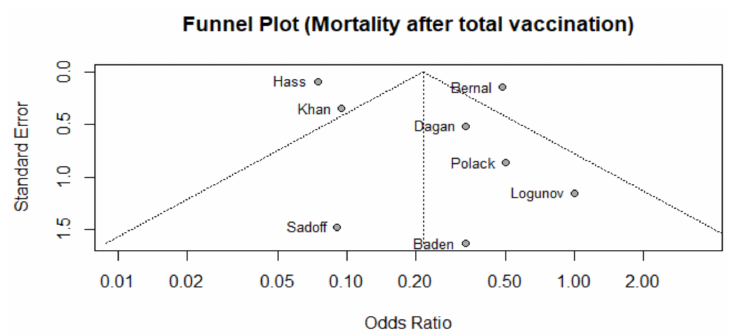
Figure 2. Funnel plot of studies that reported mortality after 2nd dose among vaccinated